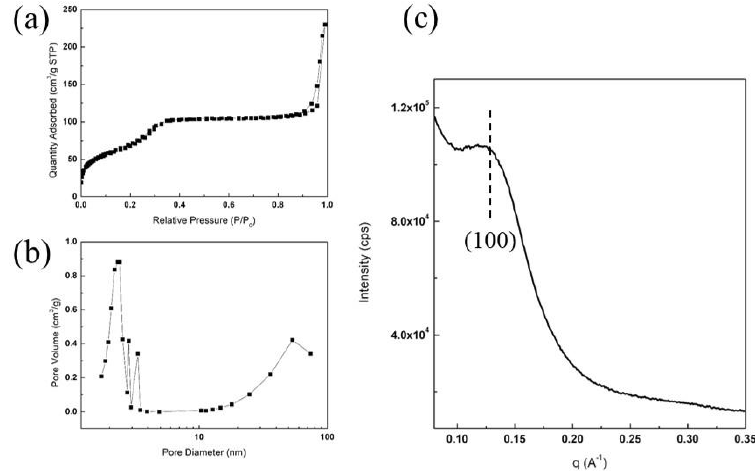
Figure 4. N 2 -physisorption and SAXS results: ( a ) N 2 -adsorption isotherm and ( b ) pore size distribu- tion curve; ( c ) small-angle X-ray scattering pattern of fresh χ -Fe 5 C 2 @SiO 2 _H catalyst.